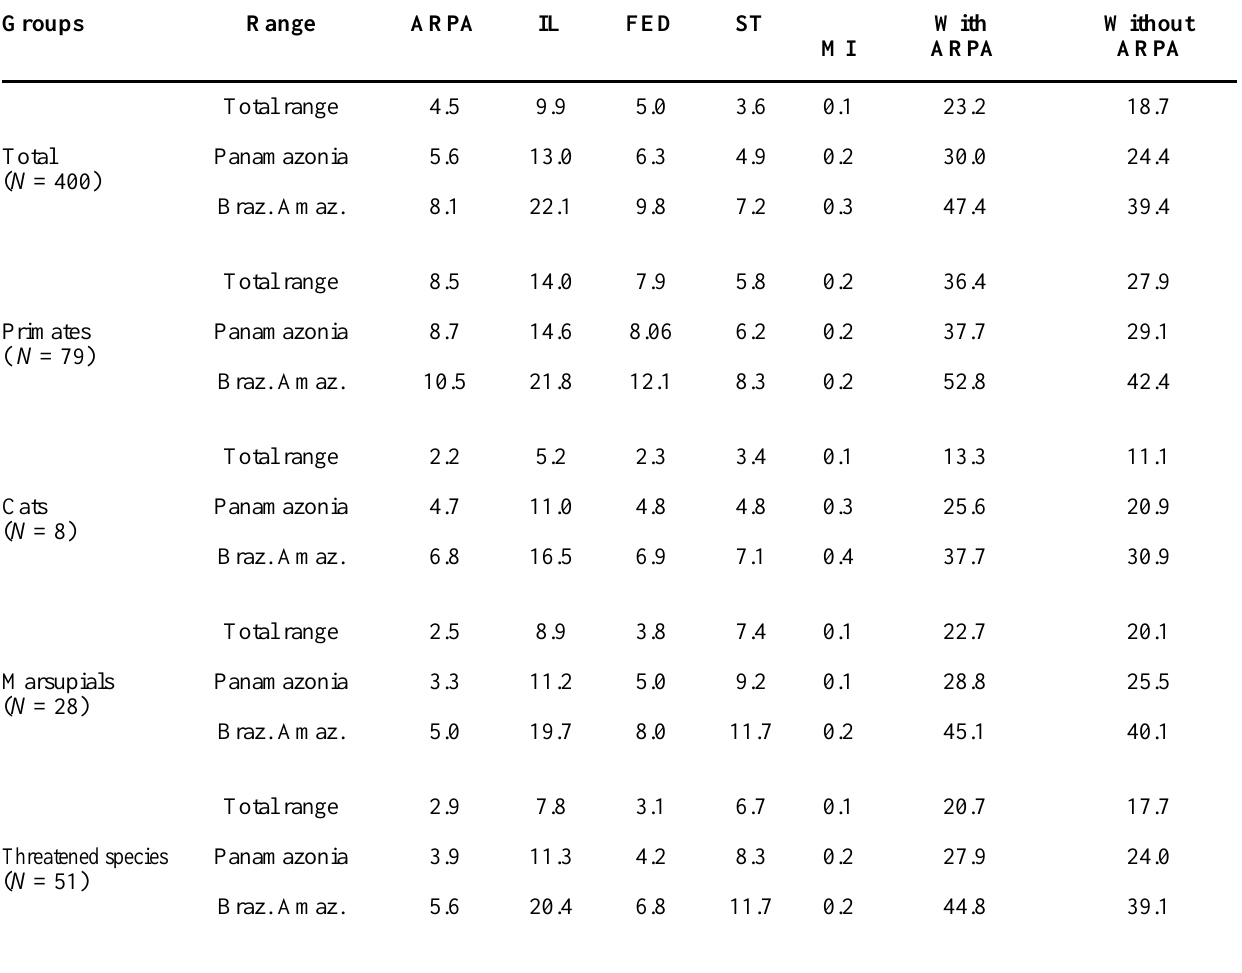
Table 2. Percentage of overlap between mammal ranges and protected areas in the Brazilian Amazon, considering their total range, part of their ranges in Amazonia, i.e., “Panamazonia”, and only part of their ranges in the Brazilian Amazon (“Braz. Amaz.”). IL = indigenous land; FED = Federal units; ST = State units; MI = military